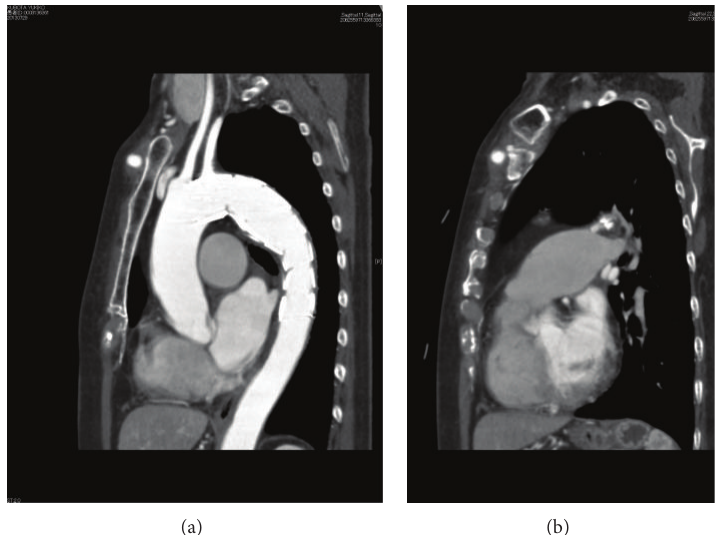
Figure 4: (a) A curved planar CT reformation image showing the TAA with stent grafts. (b) A curved planar reformation CT image showing the PDA without contrast enhancement. CT, computed tomography; PDA, patent ductus arteriosus; TAA, thoracic aortic aneurysm; LAO, left anterior